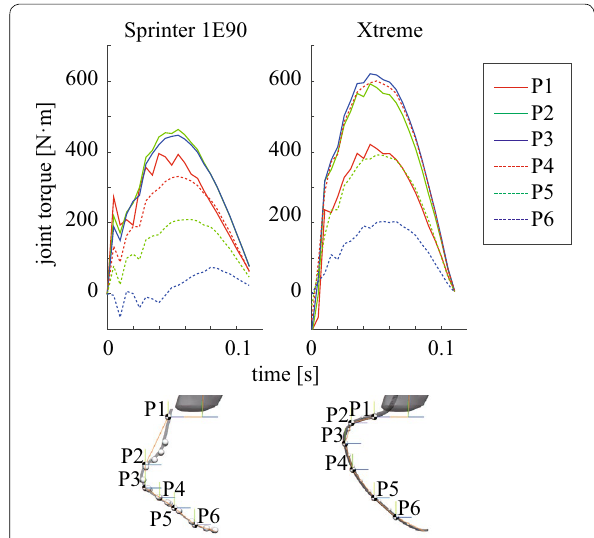
Fig. 5 RSP torques during sprinting. Horizontal axis: time, the origin of which represents the instant of the left forefoot strike, and vertical axis: flexion/extension torque whose positive value represents flexion. Left: Sprinter 1E90 and right: Xtreme. Each line corresponds to a point shown in the corresponding figure at the